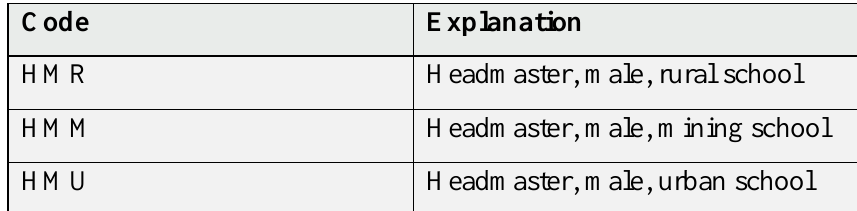
Table 5.3: Codes of individual interviews: